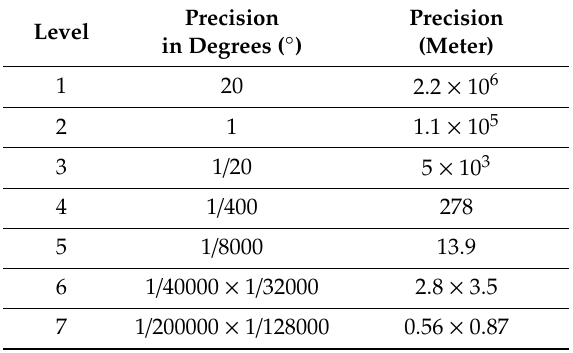
Table 1. Precision of the valid code lengths on di ff erent